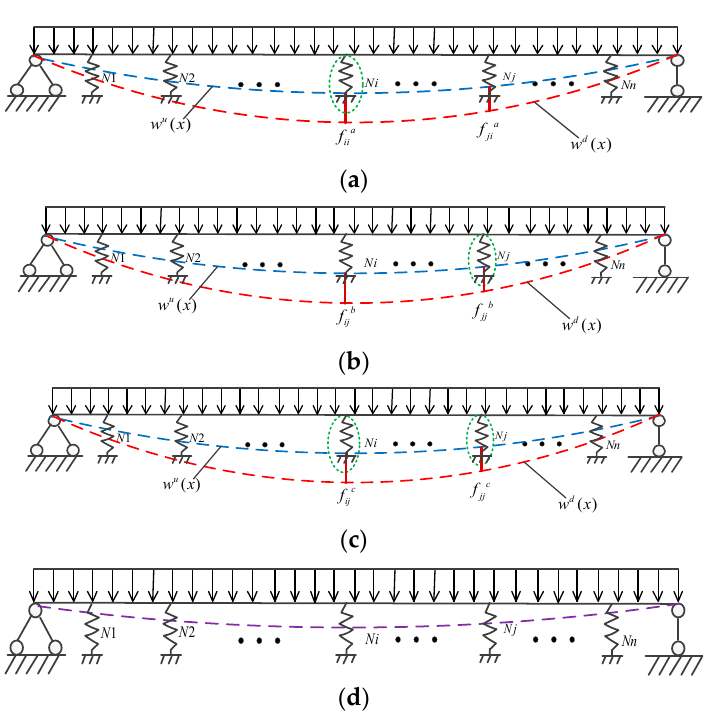
Figure 2. The difference of deflection changes between the simultaneous damage of two hangers and the two hangers damaged separately: ( a ) the damaged hanger is Ni; ( b ) the damaged hanger is Nj; ( c ) the damaged hangers are Ni and Nj ;( d ) the result of superposing the three deflections of ( a – c ). If superposing the three deflections, using the deflection difference caused by the simultaneous damage of two cables to subtract the deflection difference corresponding to the individual damage of each cable, the result will not be zero, shown in Figure 2d. This process shows that the deflection difference caused by two hangers damaged simultaneously is not equal to the sum of the deflection difference caused by the two hang- ers damaged separately. Furthermore, the difference of deflection caused by